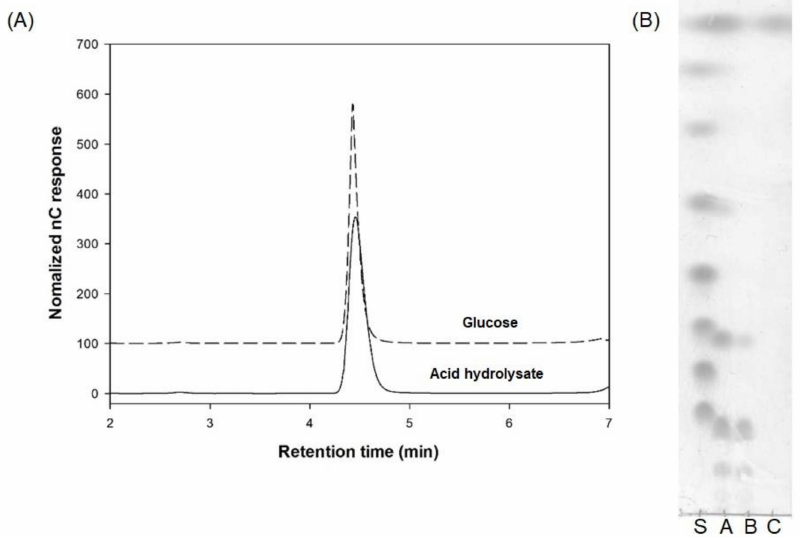
Figure 3. Carbohydrate composition of the oligosaccharides. ( A ) high-performance anion-exchange chromatography with pulsed amperometric detection (HPAEC-PAD) chromatogram of 0.1 mg glucose in 10 mL distilled water and 1 mg acid hydrolysate in 10 mL distilled water. ( B ) TLC chromatogram of the oligosaccharides before and after purification of SBC-oligosaccharides and acid hydrolysate (S, standard; A, oligosaccharides before purification; B, oligosaccharides after purification; C, acid hydrolysates of purified oligosaccharides).